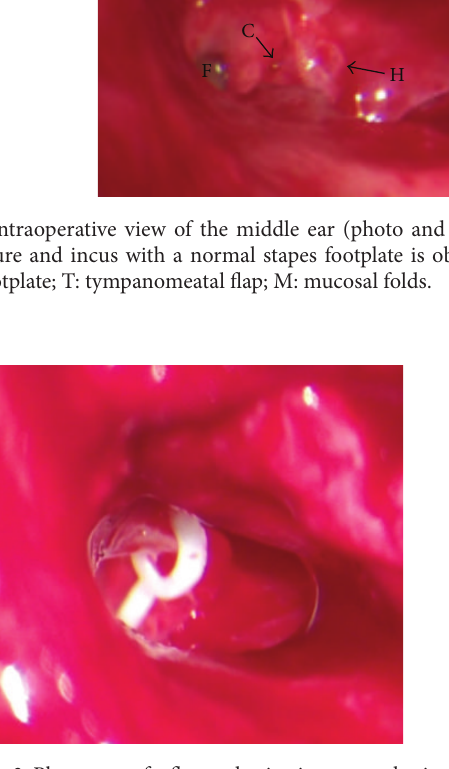
Figure 3: Placement of a fluoroplastic piston prosthesis.